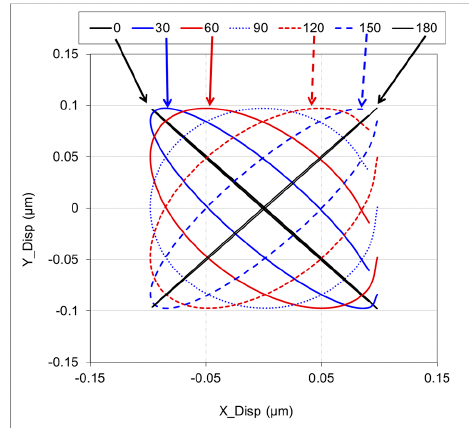
Figure 12. Response of the trajectory to the phase shift between the signals on the top and bottom